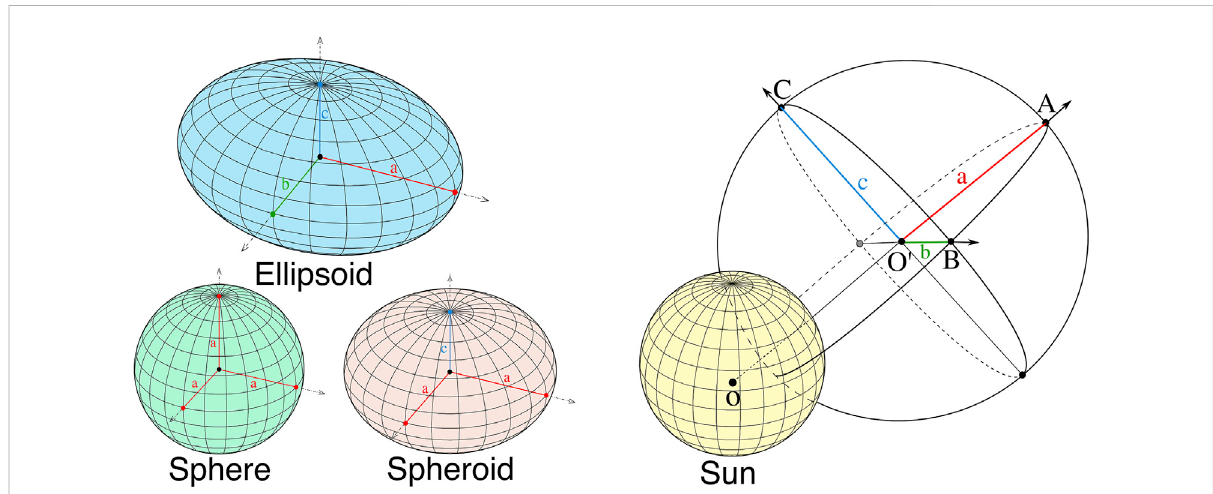
FIGURE 3 A schematic of three different ellipsoids (left), and of an ellipsoid model showing the different axis and parameters (right).